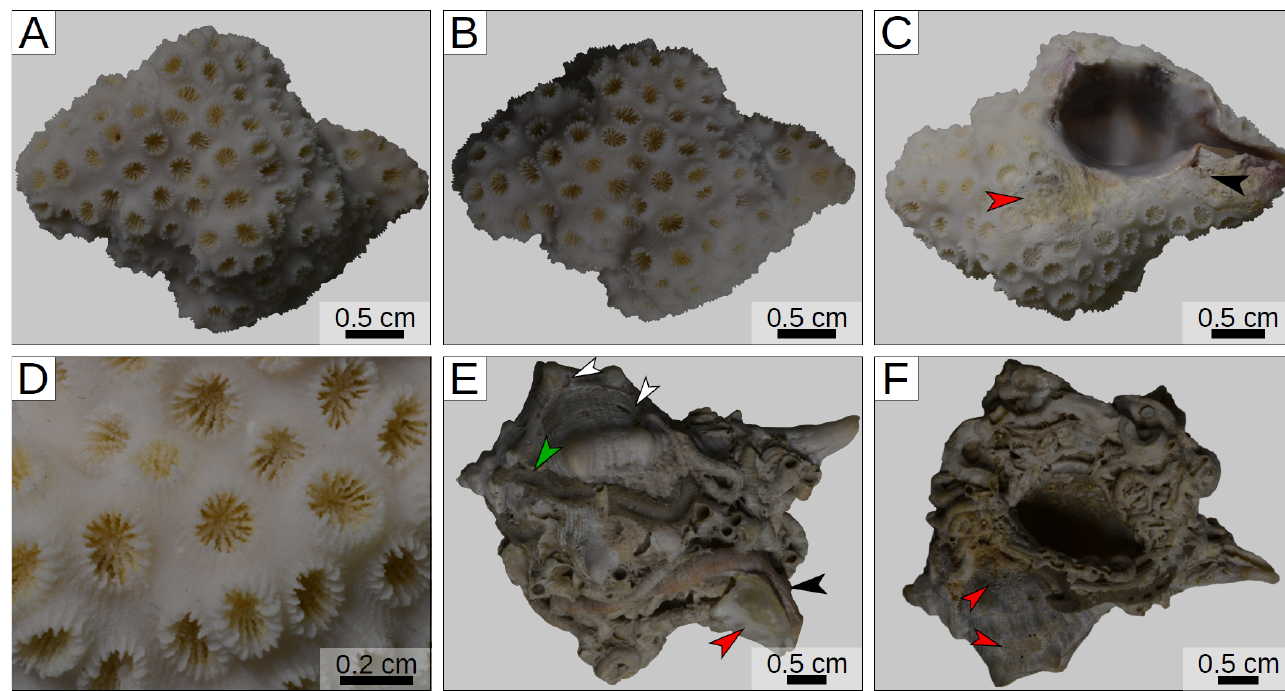
Figure 2. Recent specimens. ( A , B ) Abapertural views of the Recent muricid from Glyfada (Greece), encrusted by Oculina patagonica , taken under different light conditions to better highlight the shape of the shell. ( C ) Apertural view of the Recent muricid from Glyfada; red arrowhead indicates the only portion of the shell that is not encrusted by the coral, black arrowhead indicates the serpulid worm tube that occurs close to the apertural end of the siphonal canal. ( D ) Detail of the O. patagonica corallites. ( E ) Abapertural view of the Recent muricid displaying evidence of having been used by a hermit crab; white arrowheads indicate boreholes; green arrowhead indicates an agglutinating worm tube; black arrowhead indicates a calcareous worm tube; red arrowhead indicates an oyster. (F) Apertural view of the Recent hermitted muricid displaying sclerobiont encrustations extending into the body chamber; red arrowheads indicate bryozoan encrustations.